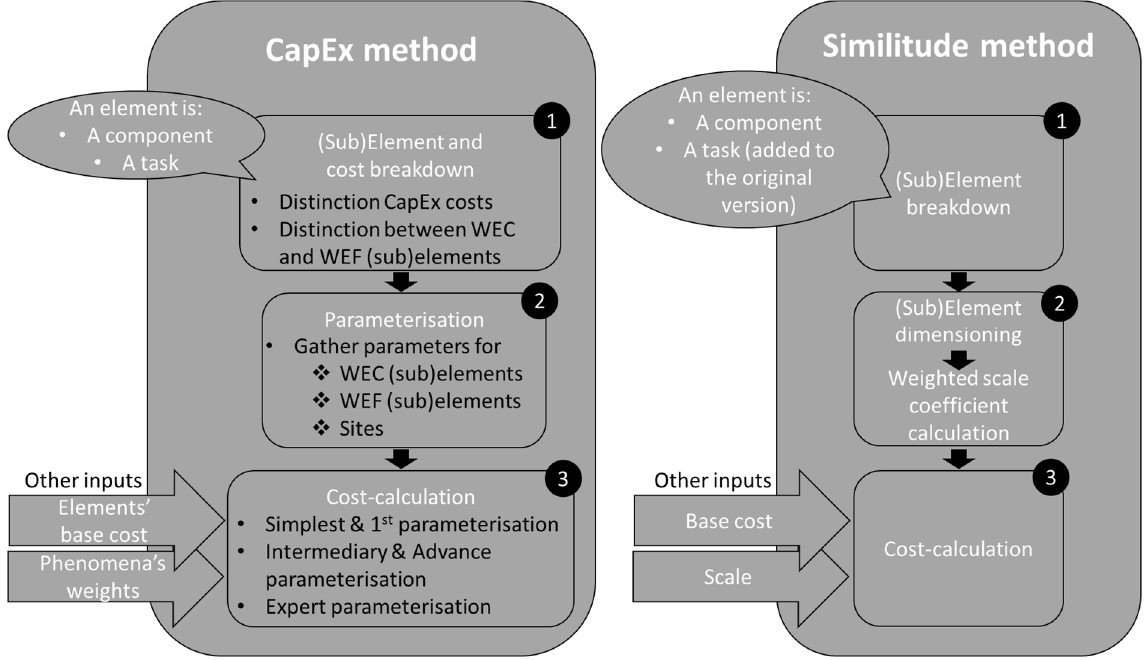
Figure 1. CapEx and Similitude method flow-chart.